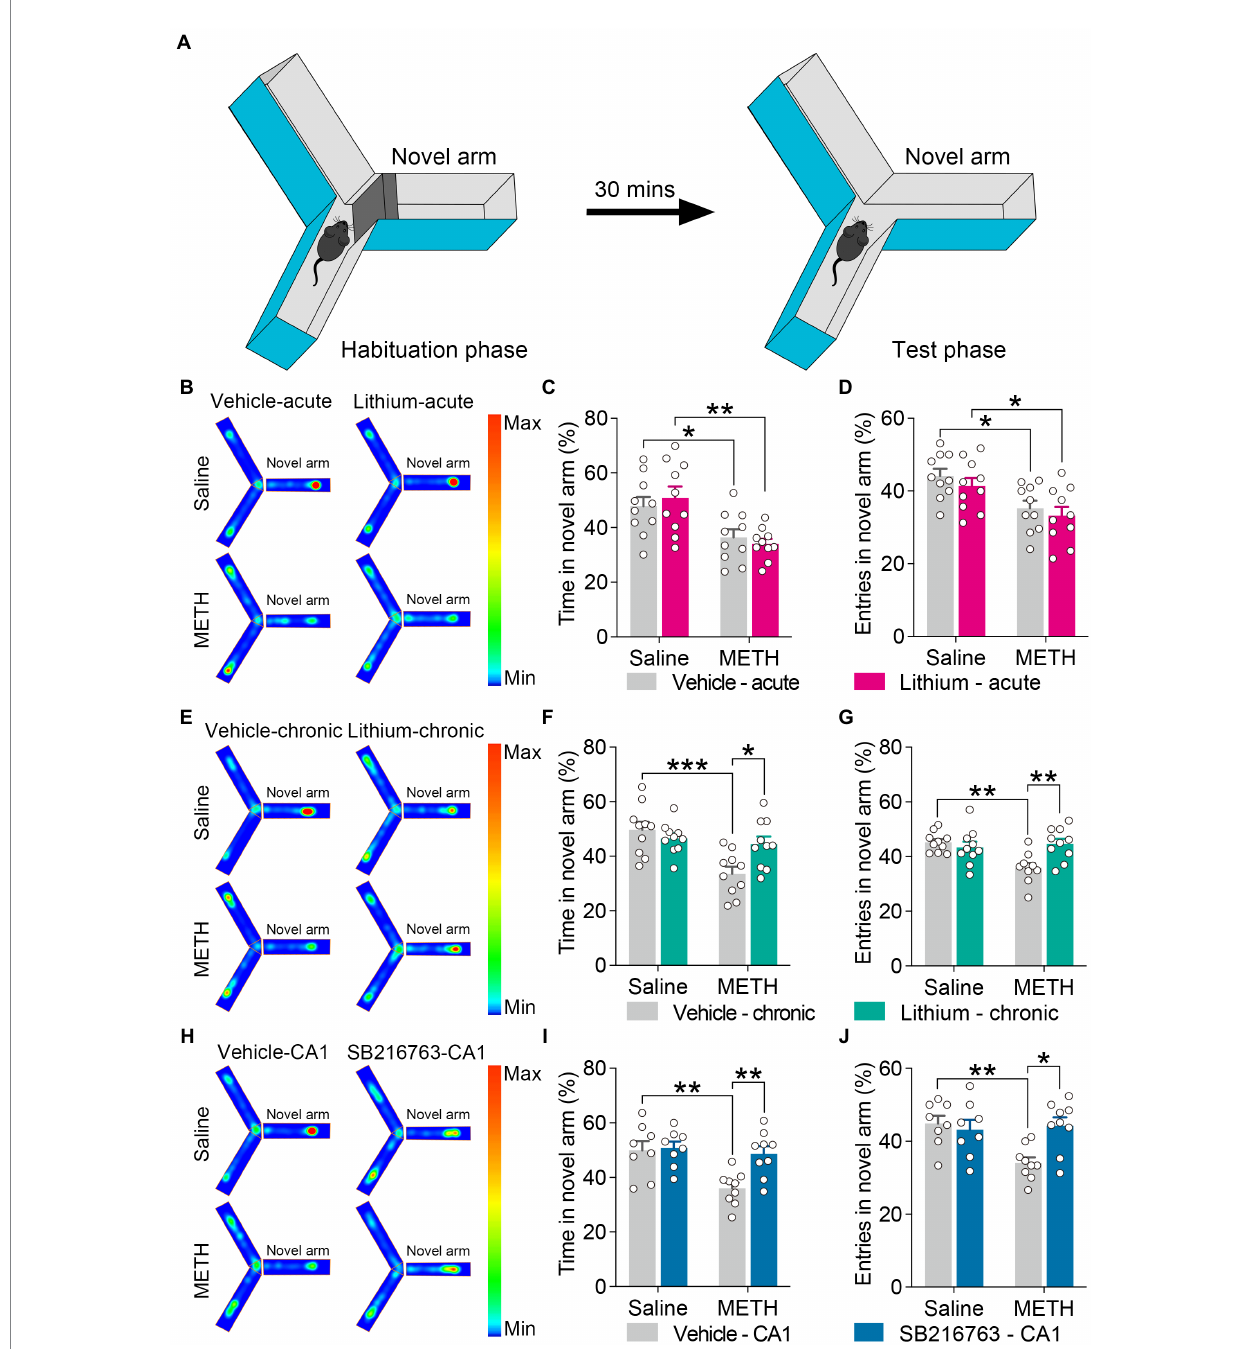
FIGURE 6 Effect of GSK3 β inhibition on adolescent METH exposure-induced spatial recognition memory impairment in adulthood. Apparatus and placements of the mice for the standard two-trial Y-maze test (A) . Compared with the effect of the acute systemic intervention (B–D) , chronic systemic intervention (E–G) and chronic intervention within CA1 (H–J) ameliorated adolescent METH exposure-induced spatial recognition memory impairment in adulthood. Representative heat maps show the location of the mice during the testing phase (B,E,H) . Histograms show the time spent (%) (C,F,I) and entries (%) (D,G,J) in the novel arm in this test. Data are presented as the mean +/ − SEM, each symbol represents the independent of a single animal; two-way ANOVA followed by the Bonferroni post hoc test; n = 8 ~ 10/group; * p < 0.05, ** p < 0.01, and *** p < 0.001, comparison between the two indicated groups. See also Supplementary Figure